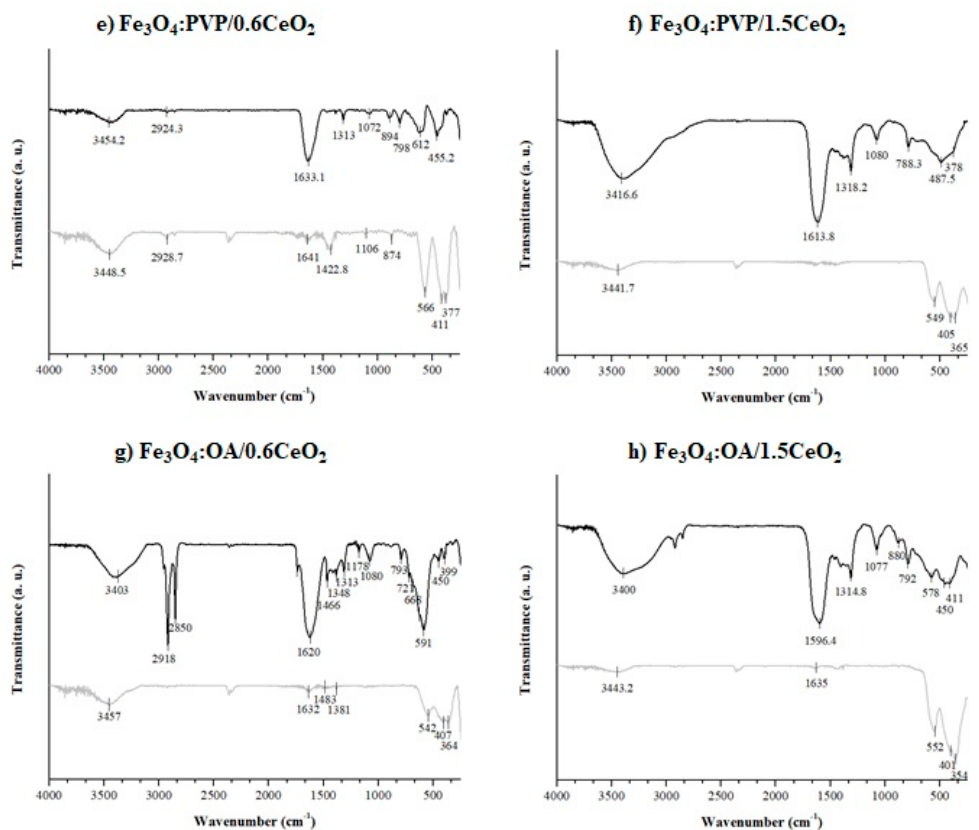
Figure 2. IR spectra of ( a ) Fe 3 O 4 / 0.6CeO 2 ( b ) Fe 3 O 4 / 1.5CeO 2 , ( c ) Fe 3 O 4 :CITR / 0.6CeO 2 , ( d ) Fe 3 O 4 :CITR / 1.5CeO 2 , ( e ) Fe 3 O 4 :PVP / 0.6CeO2, ( f ) Fe 3 O 4 :PVP / 1.5CeO 2 , ( g ) Fe 3 O 4 :OA / 0.6CeO 2 and ( h ) Fe 3 O 4 :OA/1.5CeO 2 , as prepared (black) and after calcination at 1000 °C (grey).